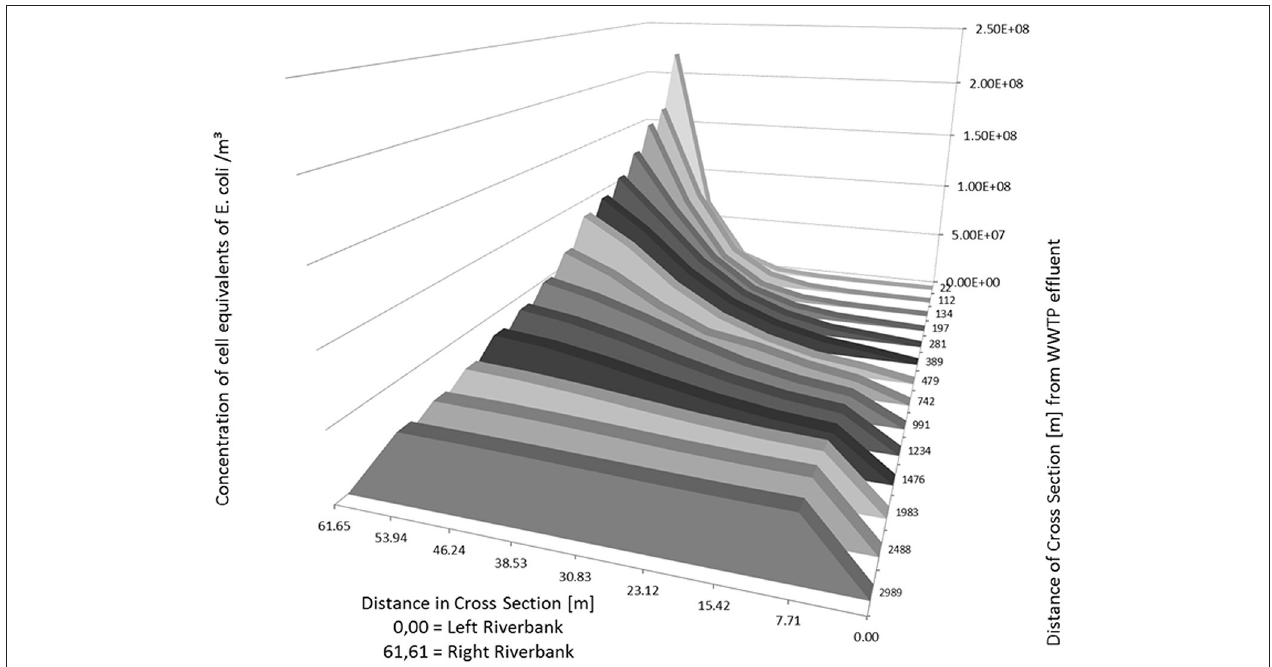
FIGURE 5 | Distribution of calculated (2D-HDWAM) concentration of E. coli in the river Danube downstream of the WWTP for different cross sections, 9.20 × 10 8 cell equivalents/m 3 in outlet of WWTP, discharge of Danube at 22 m 3 /s (NQ).